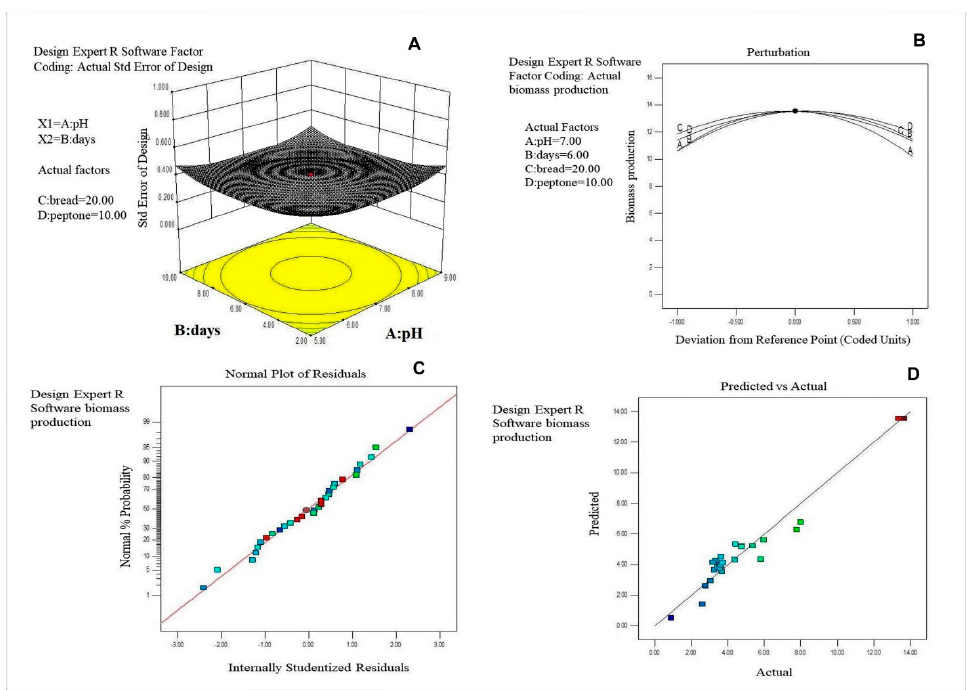
Figure 3. ( A ) Three − dimensional standard error plot for biomass production of Thraustochytrid strain TSKK1 ( Thrausto- chytrium kinnei ). ( B ) Perturbation plot for biomass production. ( C ) Normal plot for the residuals and normal percentage of probability for the response of predicted and experimental values. ( D ) Predicted and actual experimental response for the biomass production.